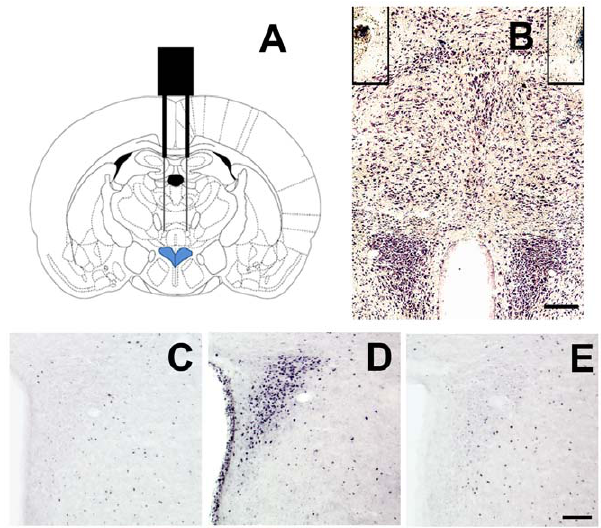
Figure 4. Ghrelin can be microinjected exclusively into the PVN. Panel A shows a schematic diagram of a coronal section of the mouse brain with the localization of a correctly implanted cannula (black). This experimental strategy allowed us to administer vehicle, containing or not ghrelin, 500 m m above the PVN (blue) via the injector cannula (gray). Panel B shows a representative photomicrograph of a coronal brain section subjected to thionin staining of an intra-PVN injected mouse. Lines label injector cannula tracts, where no thionin staining is observed. Panels C , D and E show representative photomicrographs of brain sections, containing the PVN, subjected to immunohistochemistry using anti-c-fos (purple-black staining) antise- rum in ‘‘saline-treated’’, ‘‘ghrelin-hits’’ and ‘‘ghrelin-misses’’ groups, respectively. Scale bars, 100 m m.